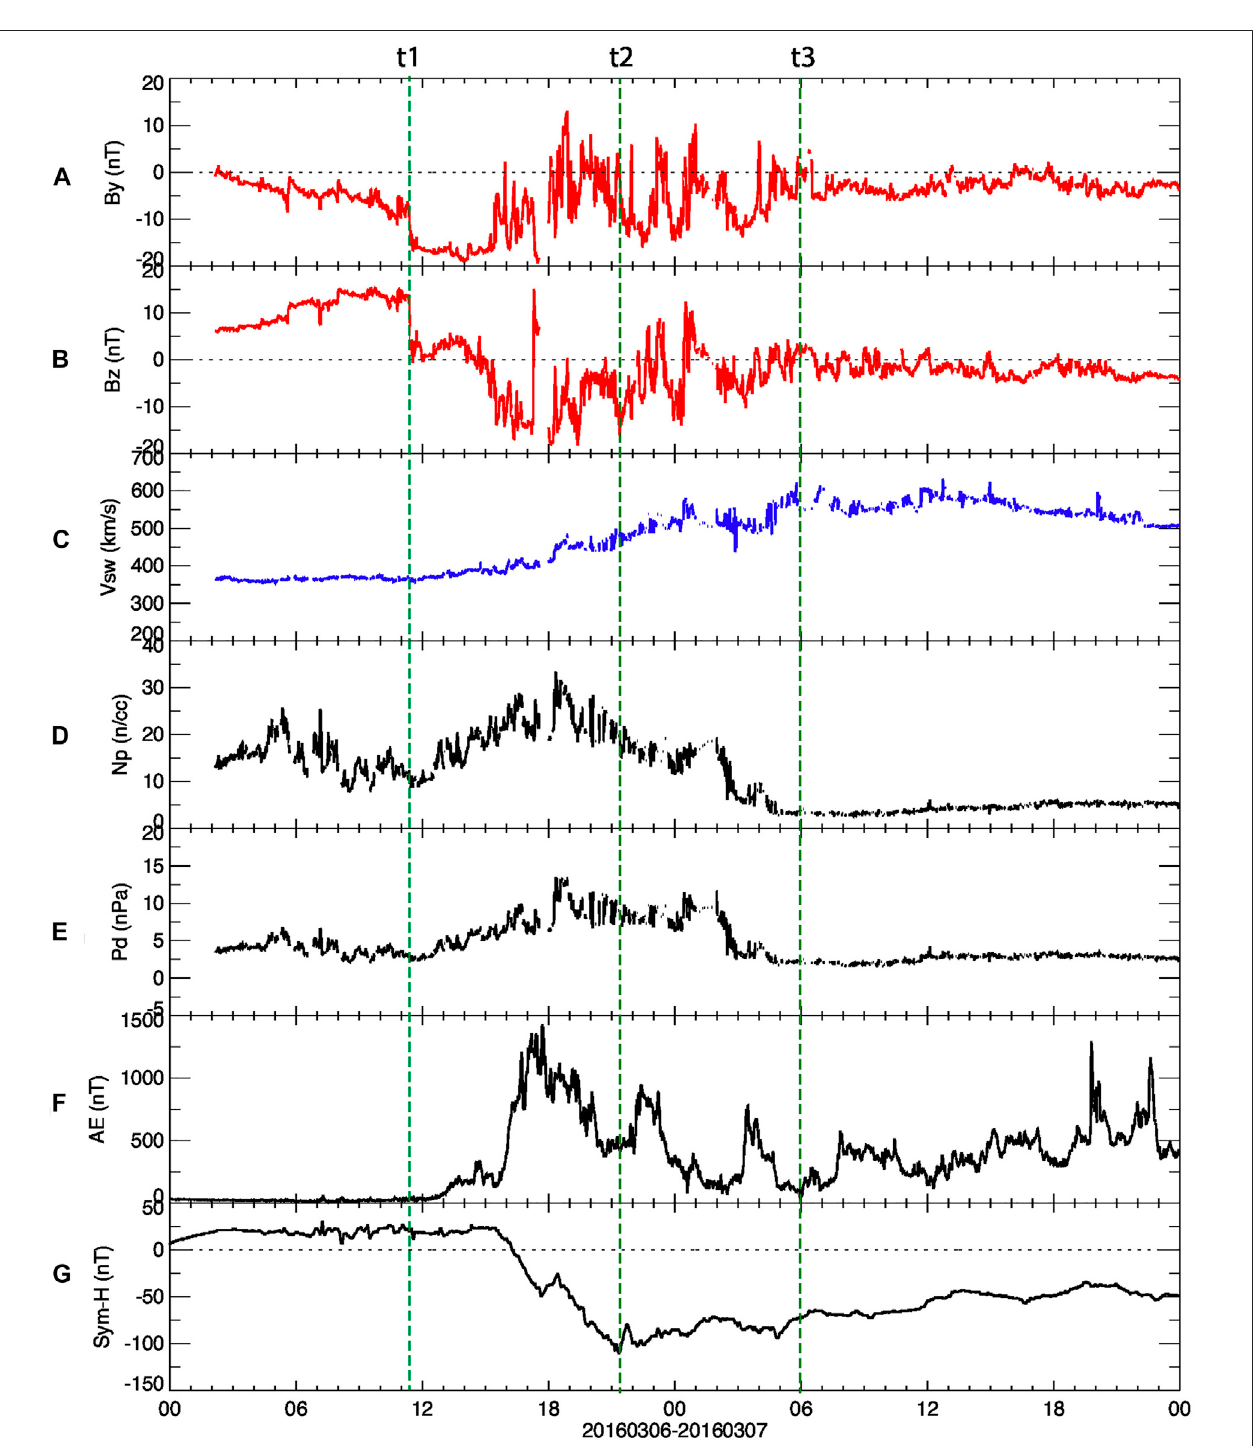
FIGURE1| SolarwindandIMFobservationsforMarch06 – 07,2016.Fromtoptobottom, (A) IMFBy, (B) IMFBz, (C) solarwindspeed, (D) protonnumberdensity, (E) dynamic pressure, (F) auroral electrojet index (AE), and (G) Sym-H index are shown. The IMF components are shown in Geocentric Solar Magnetospheric (GSM) coordinates. The three vertical lines indicate the times of sudden IMF By increase (t1: 11:47 UT on March 06, 2016), Sym-H reaching minimum (t2: 21:20 UT on March 06, 2016), and ending of large IMF fl uctuation (t3: 06 UT on March 07).